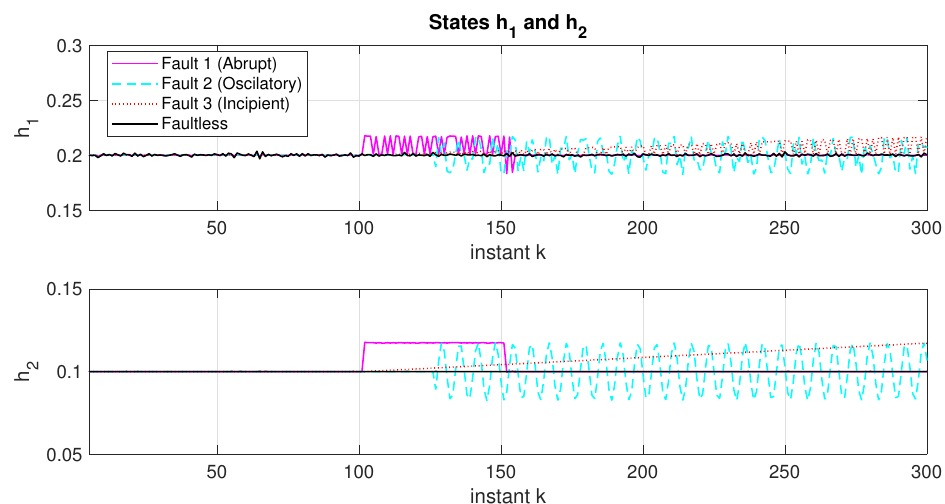
Figure 6. System states when subjected to all three faults, where the magenta curves denote the states with an abrupt fault, the cyan curves represent the states for the oscillatory fault, and brown curves are the states results for the incipient fault. The black curves represent the state without